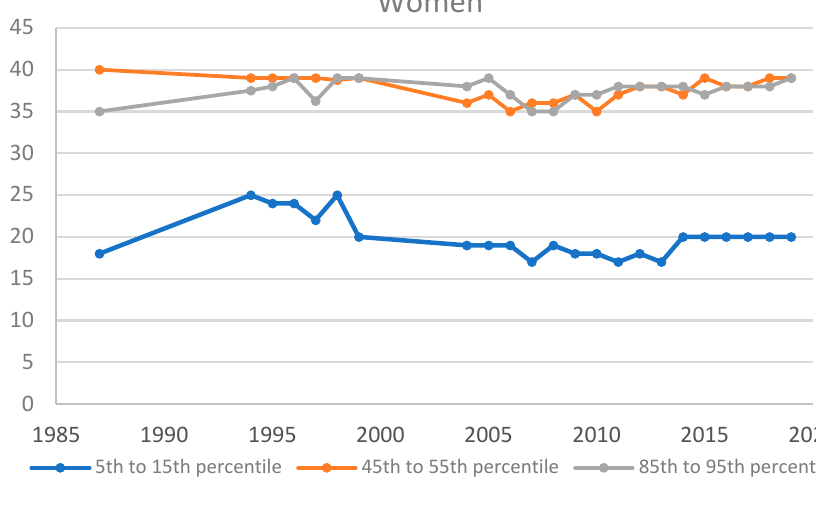
5% lower than their 1987 level in 2019. Men’s hours of work did not experience the same recovery after the financial crisis and, in 2019, were 10% lower than their level in 1987. Figure 3 explores the evolution of hours worked by men and women in more detail. Average weekly hours of work are shown at selected percentiles of the male and female weekly-earnings distribution. The average hours worked by women around the 50th and 90th percentile of women’s weekly earnings have followed similar patterns since 1987, averaging almost 40 per week until 2007. During the financial crisis, average hours worked by middle and high earning women decreased to a low of 35 per week in 2010, before fully recovering to their pre-recession level in 2019.